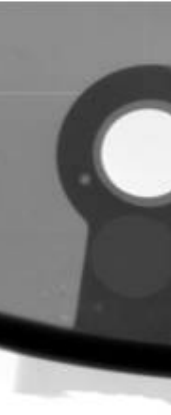
Figure 17. RTG—Sample 2.C.